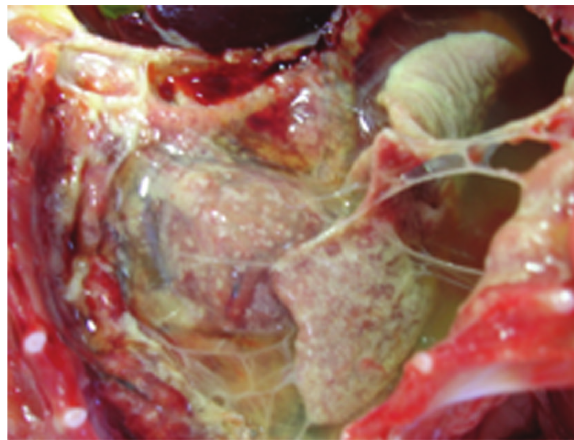
Figure 3: Pleural cavity of a cat with e ff usive FIP. Fibrinous serositis and adhesions of the lung with fibrin strands can be